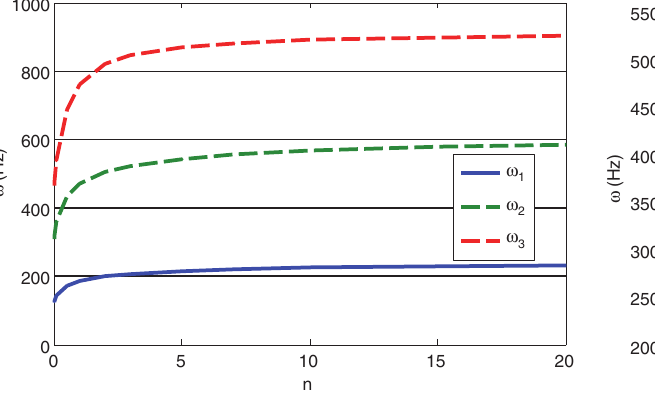
Figure 9 Variation in the first three natural frequencies of a fully clamped isotropic FG annular sector plate for different power-law exponents and θ = 200 °